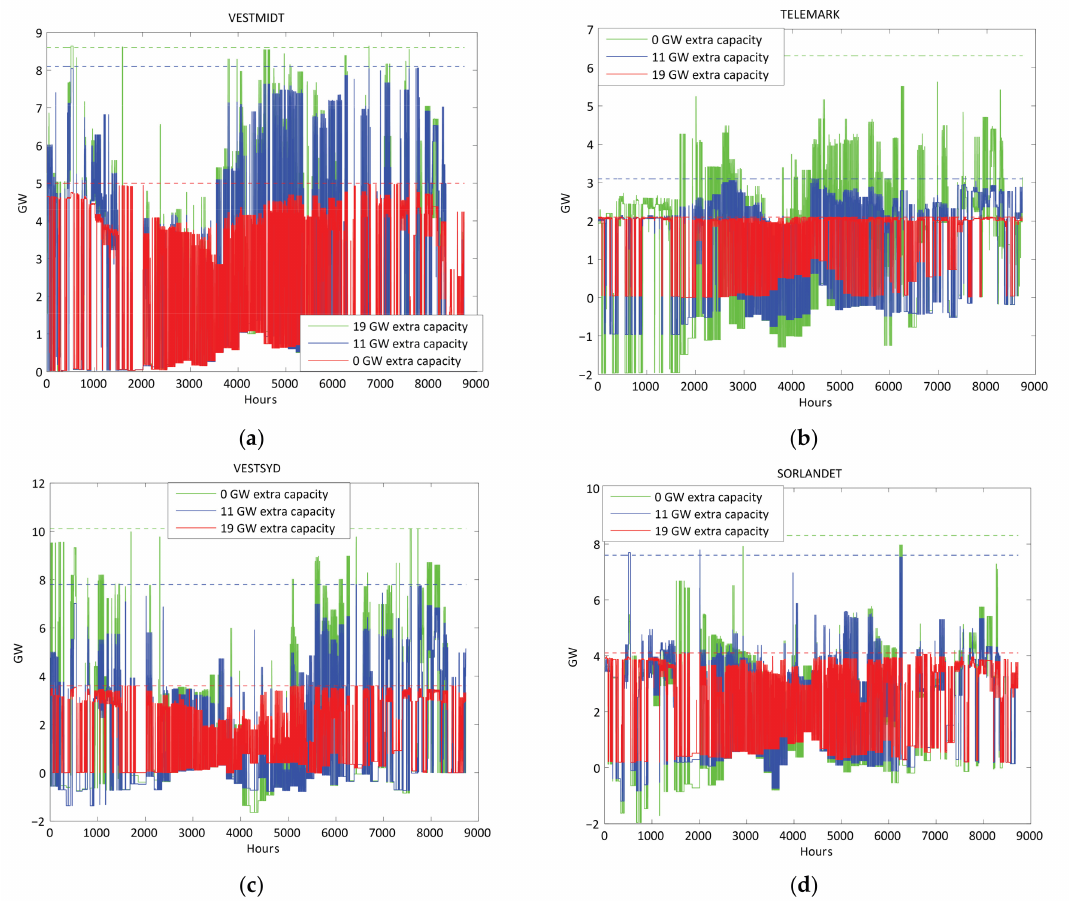
Figure 7. Production hour-by-hour for the four regions in the 38th simulation year): ( a ) VESTMIDT; ( b ) TELEMARK; ( c ) VESTSYD; ( d )